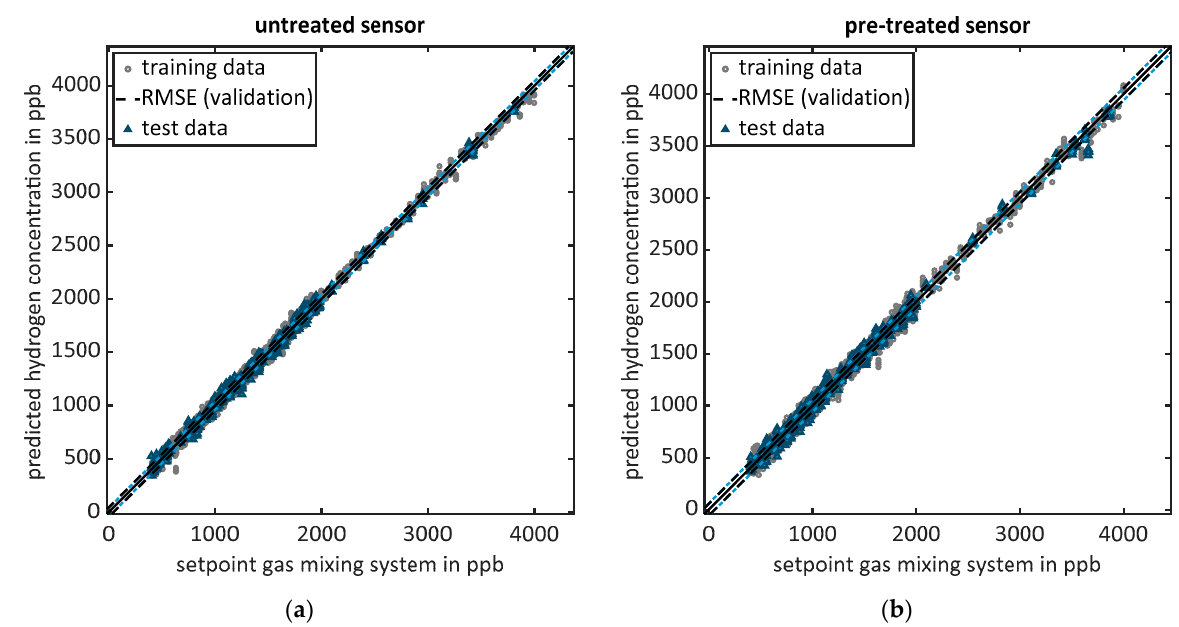
Figure 2. Partial least squares regression (PLSR) models for the prediction of H 2 concentration based on the calibration inside the lab: ( a ) untreated sensor: root mean squared error for validation (RMSE V ) = 44.8 ppb and RMSE T = 40.5 ppb; ( b ) sensor pre ‐ treated with siloxane: RMSE V = 56.0 ppb and RMSE T = 60.0 ppb. Grey circles are part of the training, blue triangles part of the independent test data (20% of the data); both PLSR models show no indication of overfitting.